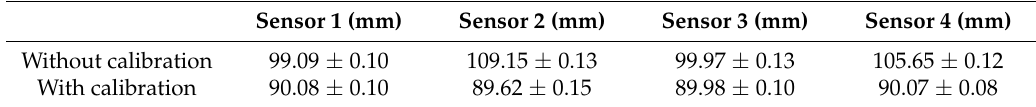
Table 1. Average value and standard deviation over 500 samples of the distances from four individuals IR range sensors embedded in the compliant wrist, without and with calibration, and ground truth distance of 90 mm.